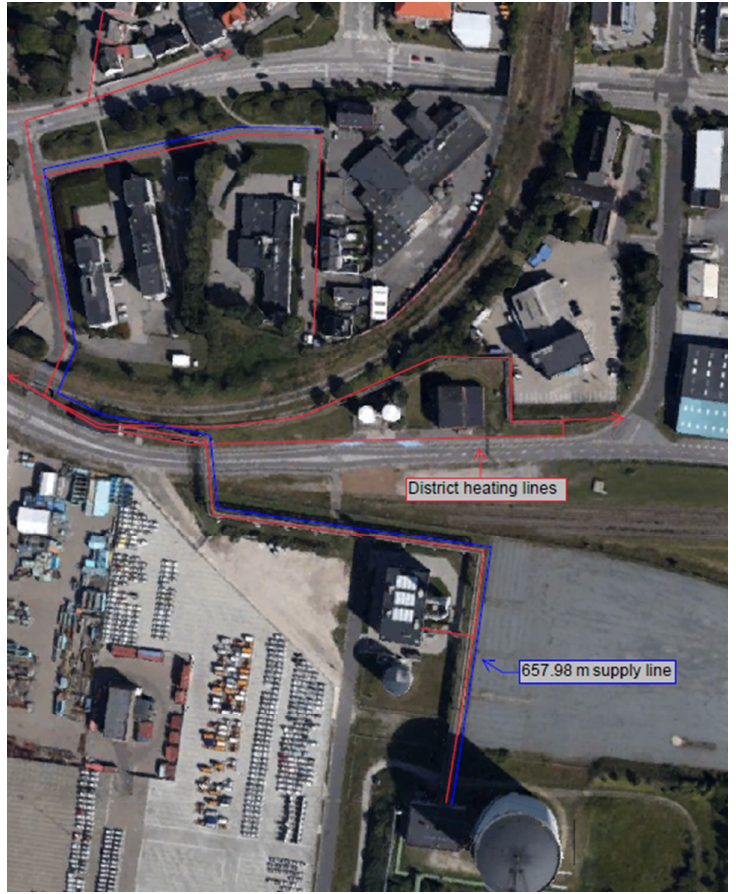
Figure 4. The map of where the district cooling system is to be developed. Energies 2020 , 13 , x FOR PEER REVIEW